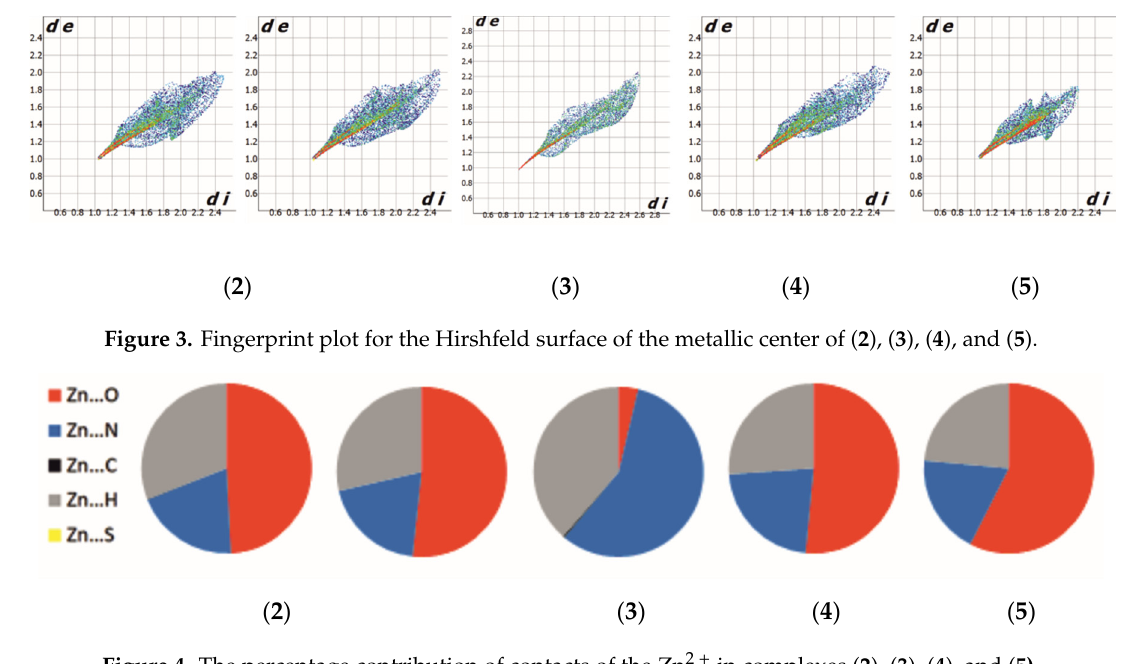
Figure 2. The Hirshfeld surface of the Zn 2+ center in ( 2 ), ( 3 ), ( 4 ), and ( 5 ) with a normalized contact distance ( d norm ) mapped on it. The parameter d norm ranges from − 0.61 to 1.14 for Zn1 and from − 0.62 to 1.12 for Zn2 ( 2 ); from − 0.64 to 1.42 ( 3 ); from − 0.62 to 1.26 ( 4 ), and from − 0.59 to 0.90 ( 5 ).